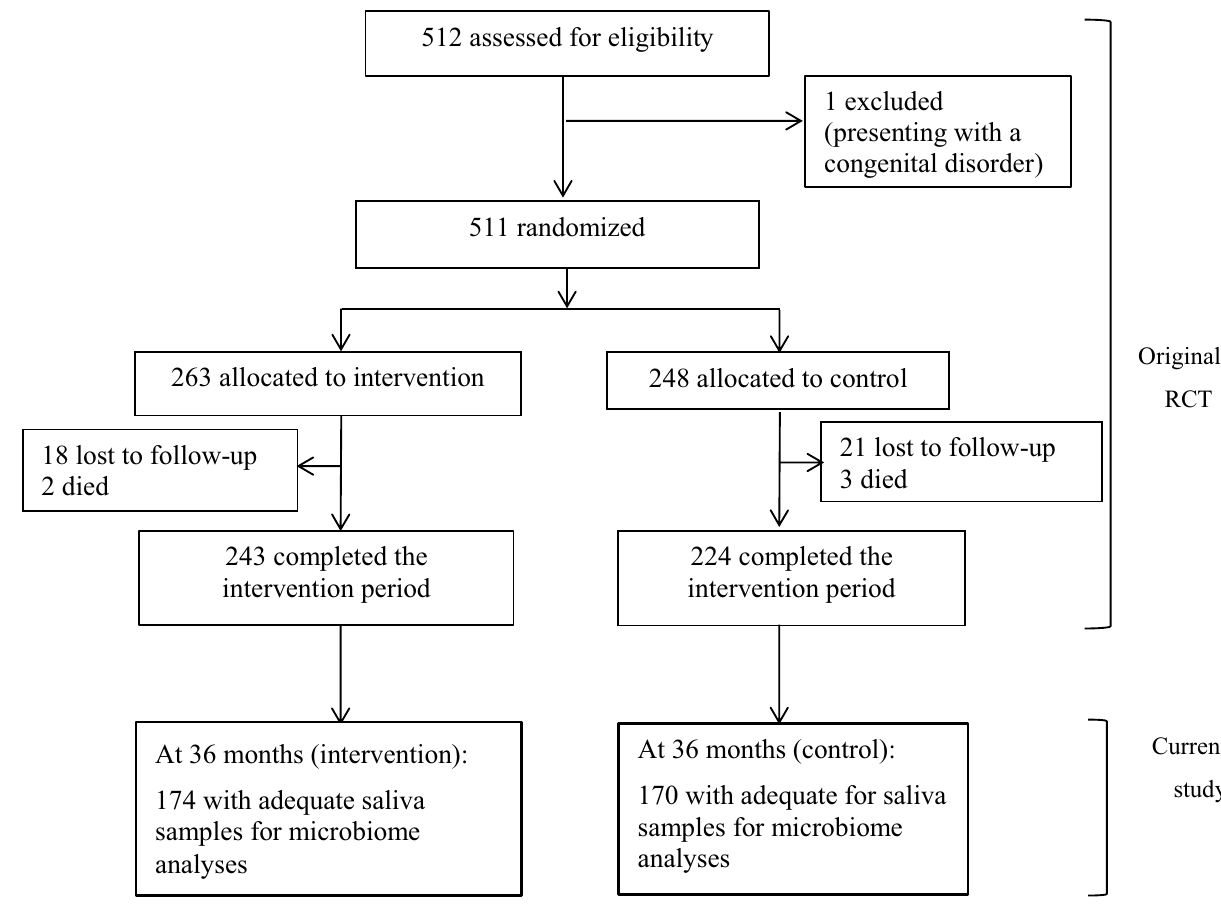
Figure 2. Flowchart showing the inclusion of study participants into the original trial and the current follow-up study. RCT, randomized controlled